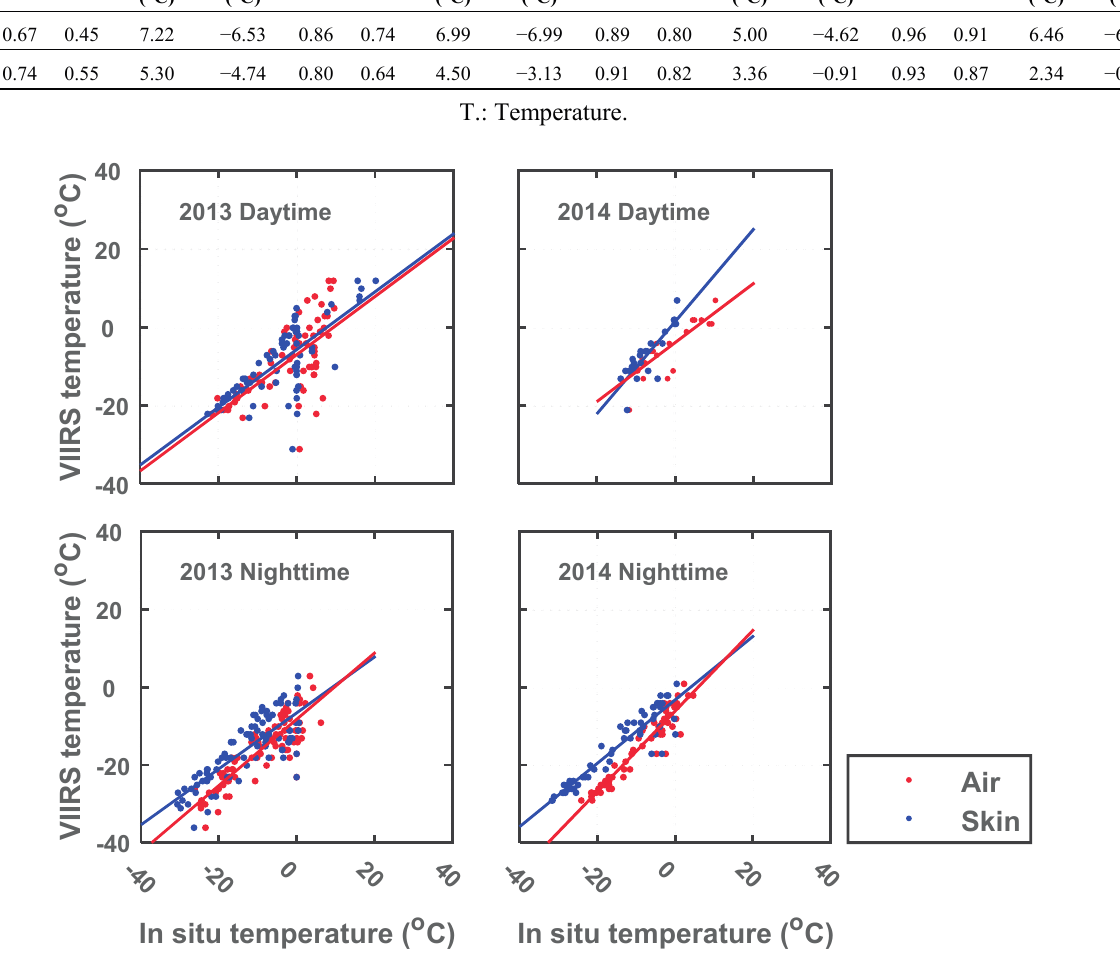
Figure 9 . CREST-SAFE in situ T-skin and T-air vs. satellite VIIRS LST daytime and nighttime data for the forest/vegetation covered pixel scatterplots for winters 2013 and